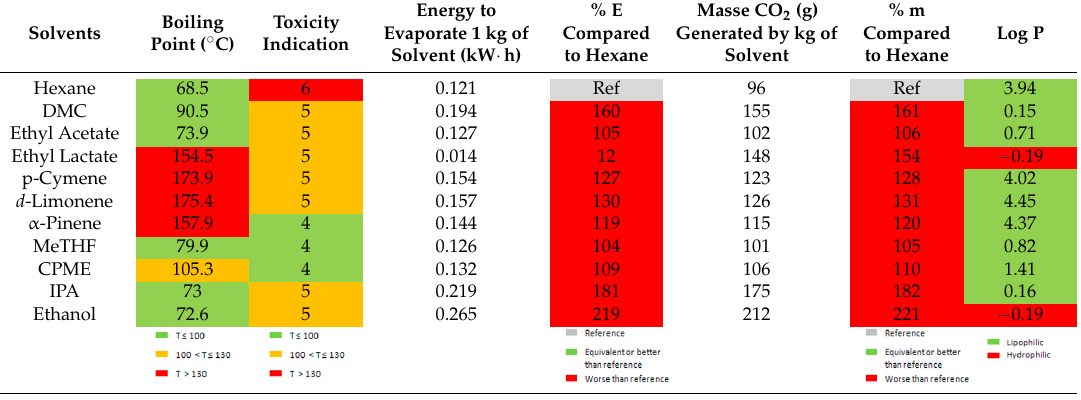
Table 2. Economic and environmental studies allow one to have an idea of better solvents for microbial extraction in industry.